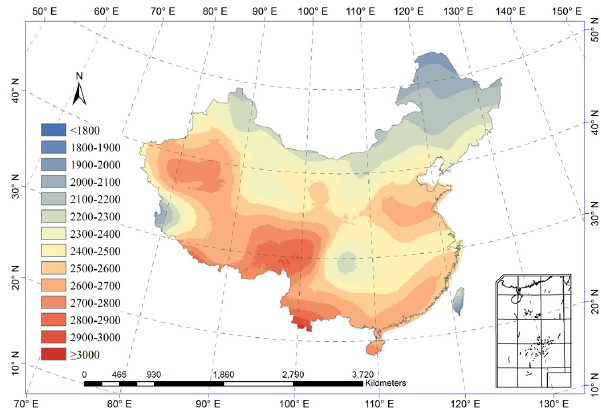
Fig. 2. Spatial distribution of perennial average of annual diffuse radiation in China during 1981–2010 (Unit: MJm − 2 yr − 1 )